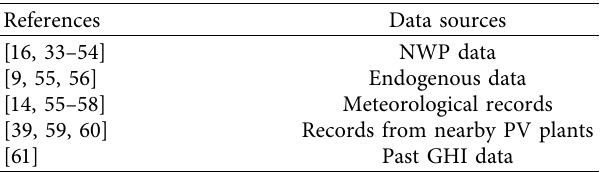
Table 3: Summary of the literature review in data sources for the intraday time